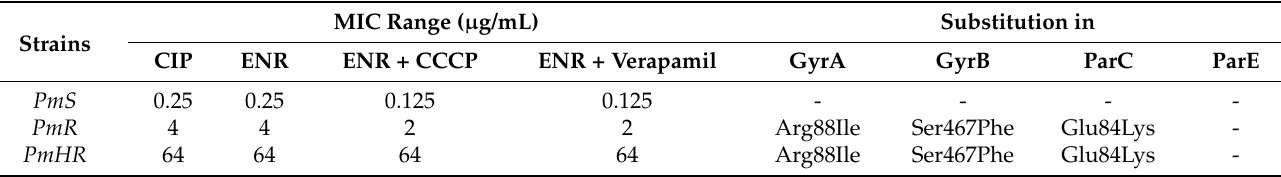
Table 1. QRDR mutation genotypes and fluoroquinolone MICs for PmS , PmR and PmHR